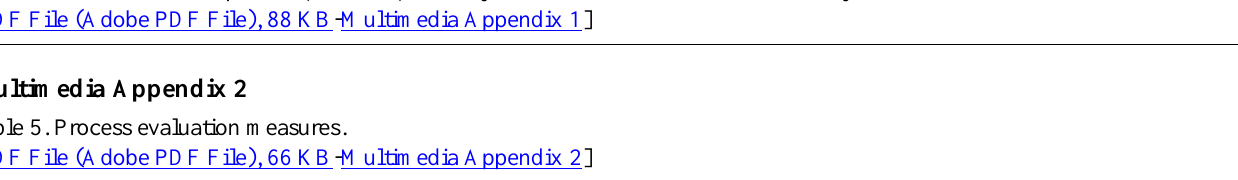
Table 4. Intervention components, attrition, usability and modes and methods of delivery.